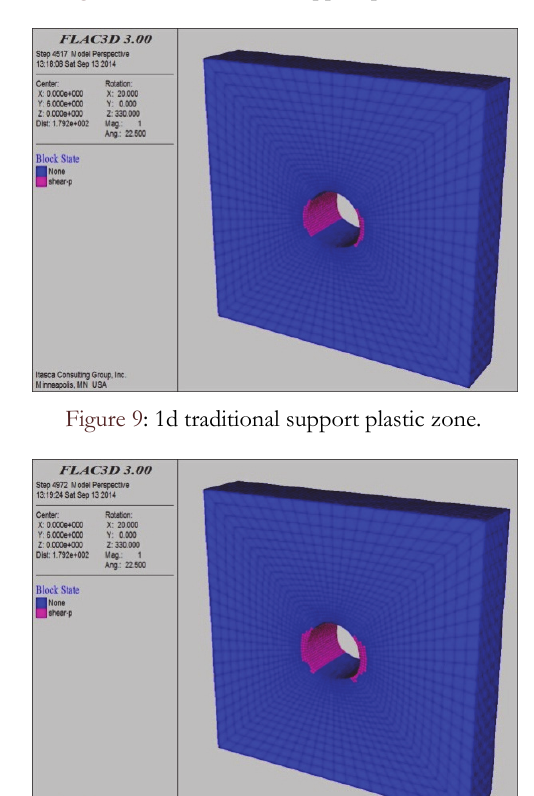
Figure 7: 12h traditional support plastic zone. Figure 8: 12h new support plastic zone.